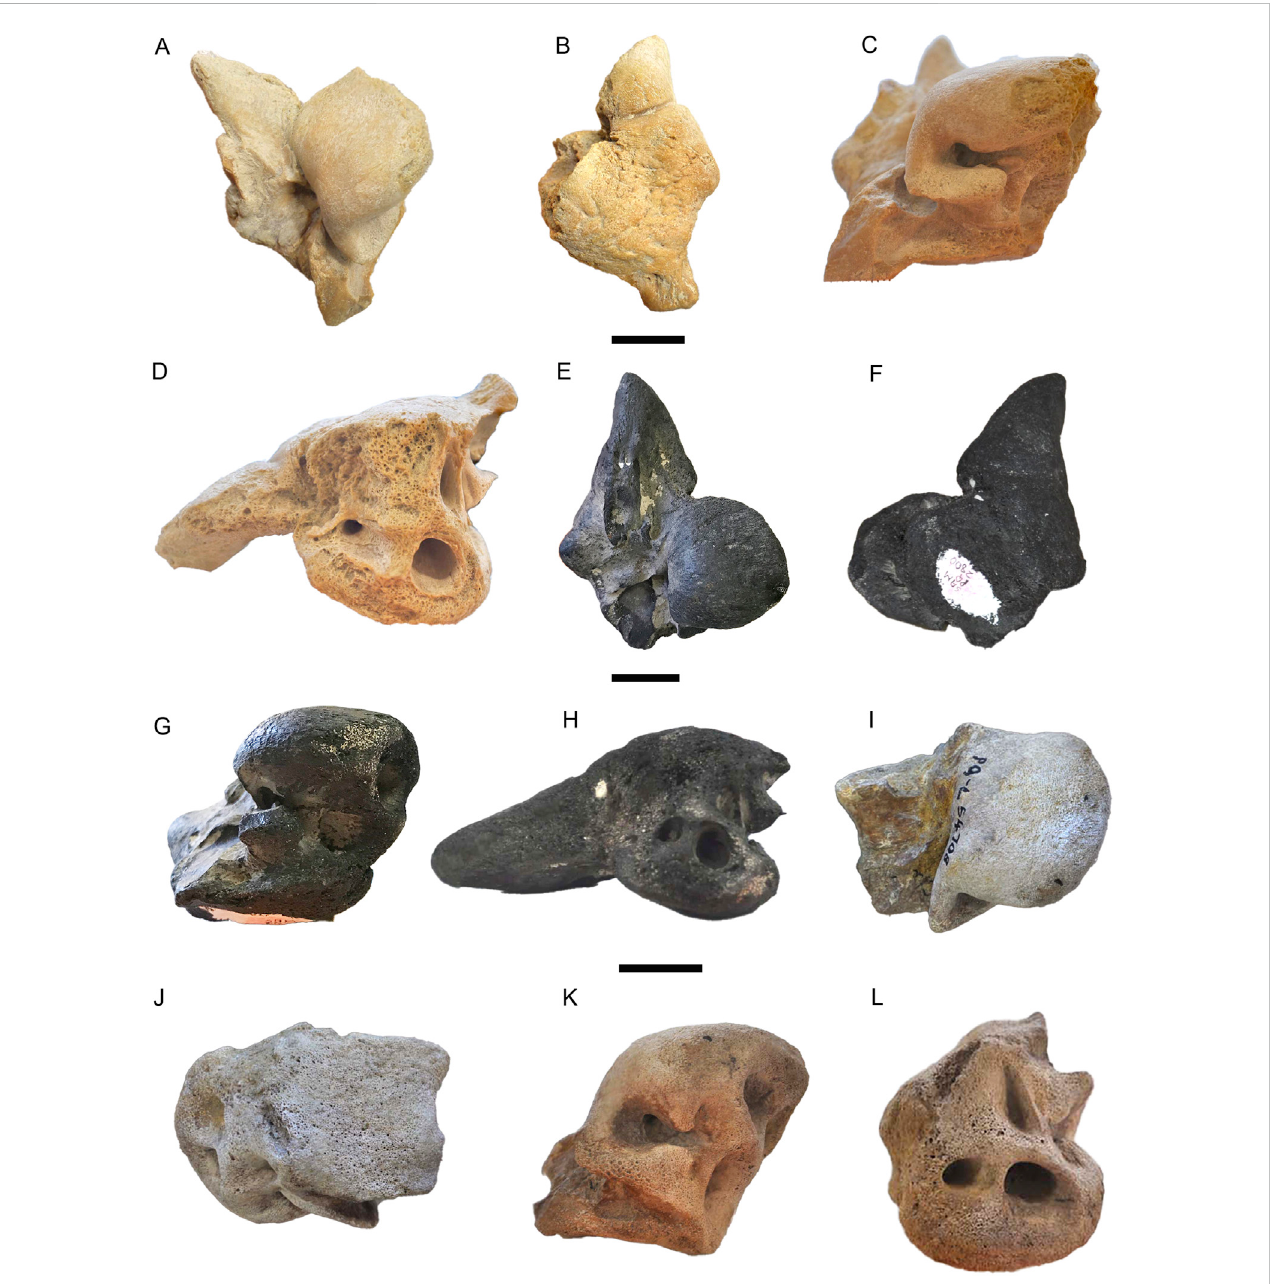
FIGURE 3 Fragilicetus sp.SAM-PQSS-224in (A) medial, (B) lateral, (C) posterior,and (D) dorsalview,scale=2 cm.PQMT-2800in (E) medial, (F) lateral, (G) posterior, and (H) dorsal view, scale=2 cm. SAM-PQL-54708 in (I) medial, (J) lateral, (K) posterior, and (L) dorsal view, scale=2 cm.